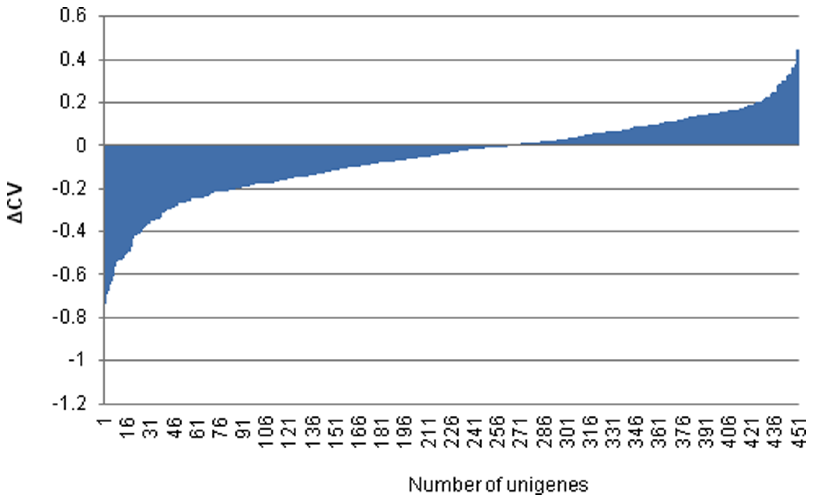
Figure 2. Coefficients of variation predominantly decrease after omission of fruit series. Change of the CV after the omission of the transcriptome fruit libraries over 451 unigenes.